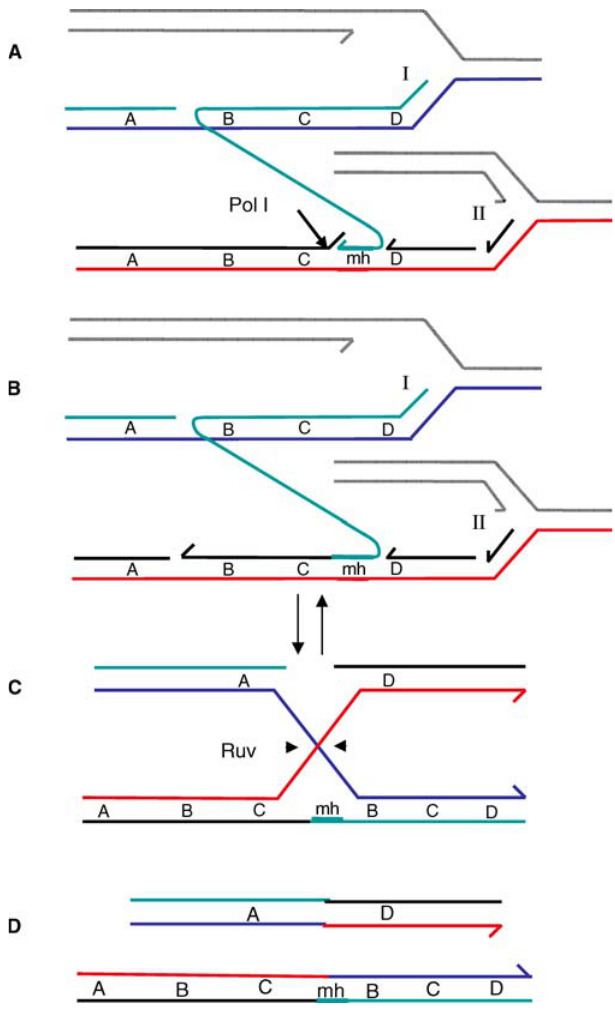
junction. Each line represents a single nucleotide chain or strand. Different strands are distinguished by color. Half arrows on strands indicate 3 9 ends. The gray strands are those that are not involved in the